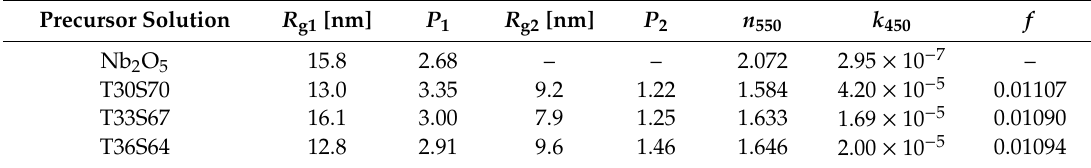
Table 1. Structural parameters of the precursor solutions and optical properties of the corresponding films. Radii of gyration, R g i and Porod’s exponents, P i (for i = 1, 2), as obtained from the Beaucage model [44]. f denotes the objective function of the optimization process by selecting di ff erent TiO 2 –SiO 2 hybrid films for the triple-layer AR coating. Precursor